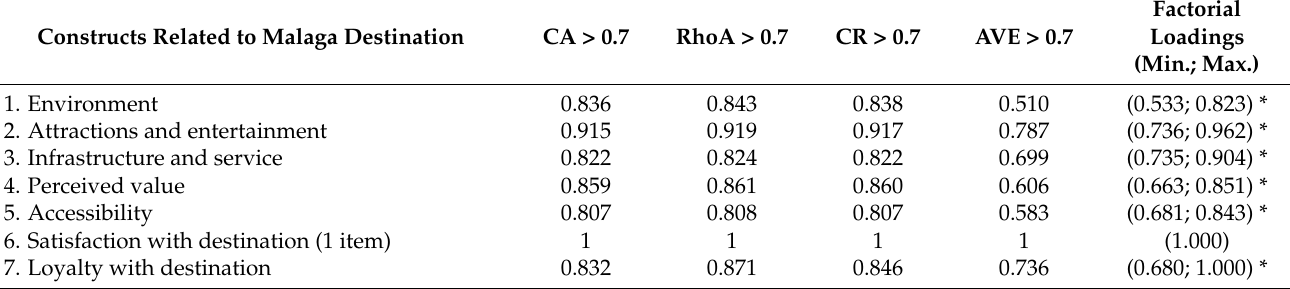
Table 3. Item reliability, internal consistency reliability and convergent validity.